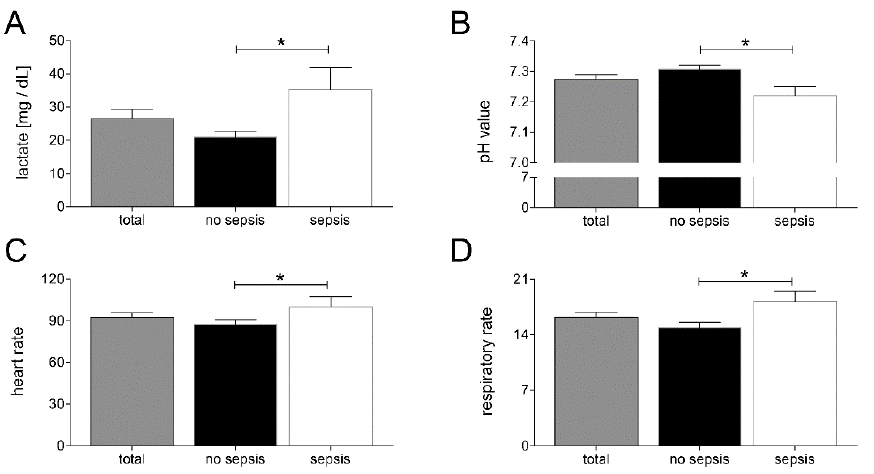
Figure 1. Upon admission of severely injured trauma patients ( n = 48) to the emergency department, lactate levels ( A ), pH values ( B ), heart rate ( C ), and respiratory rate ( D ) were measured. Patients were stratified to those who developed sepsis in their clinical course (sepsis, n = 14) vs. those who did not develop infectious complications (no sepsis, n = 34). Data are shown as mean ± SEM. * p < 0.05 sepsis vs. no sepsis.